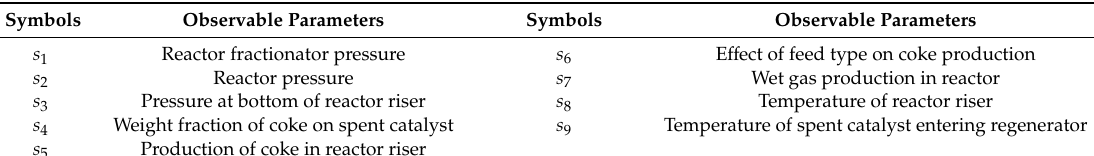
Table 5. The observable parameters of a FCCU.